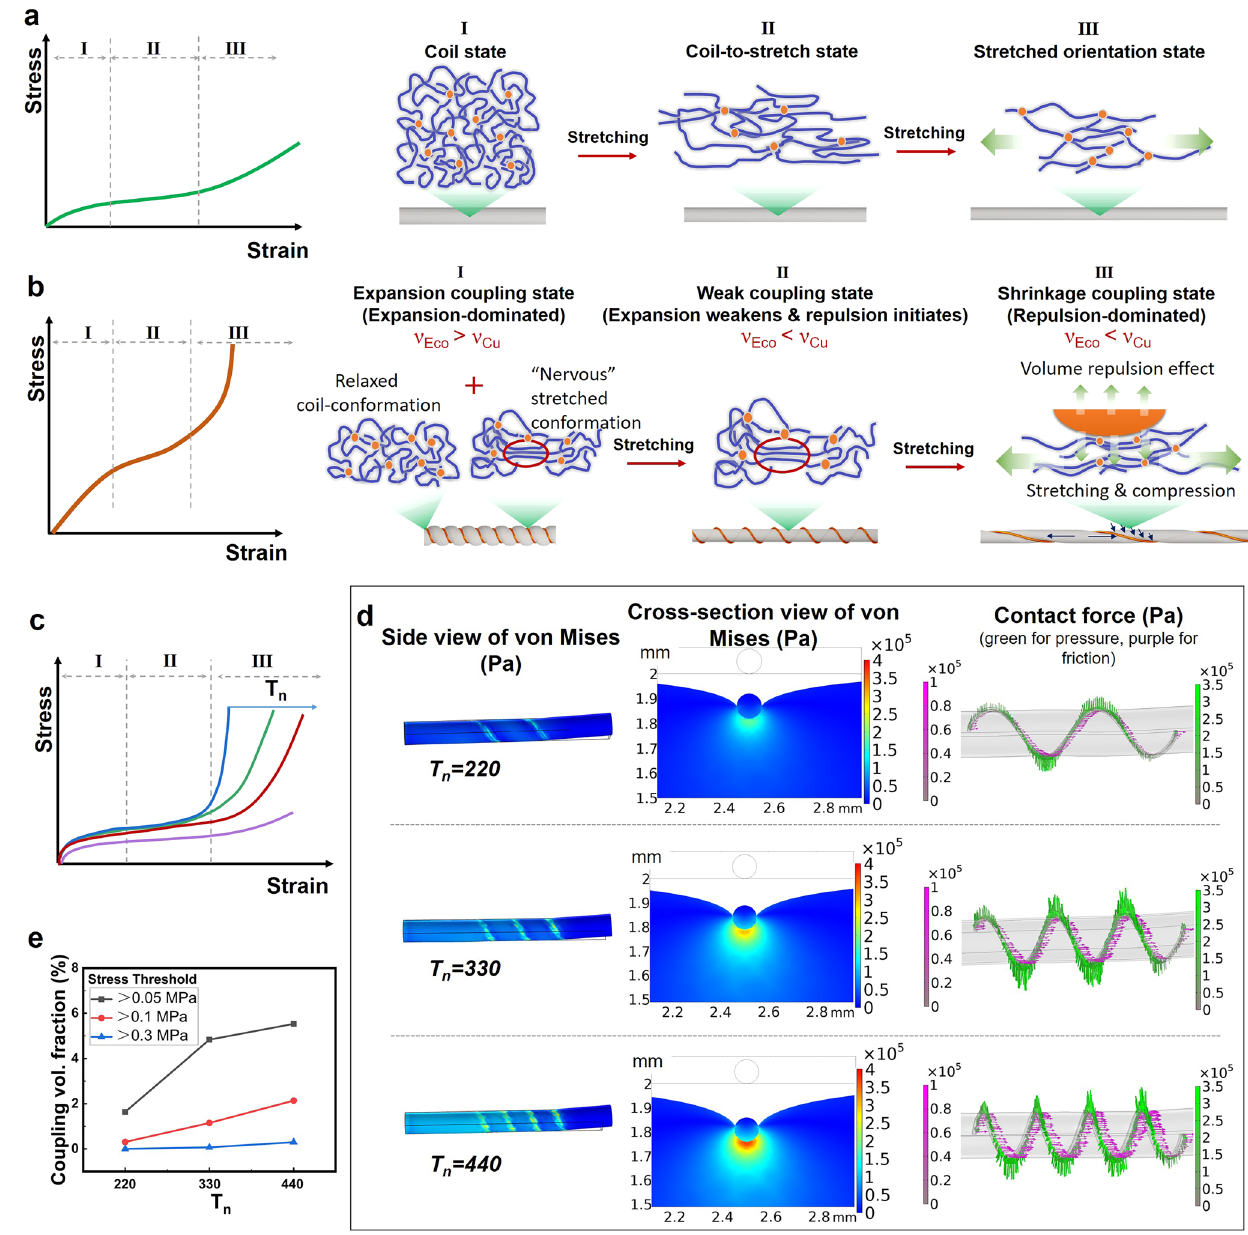
Fig. 4 A conformation coupling mechanism for understanding the mechanical properties of the HFCs. a Schematic of elastomer chain conformation changes during stretching without the coupling effects from the wire macro-helix conformation. b Schematic of the elastomer chain conformation changes for the HFC with strong coupling effects from the macro-helix conformation. ν is Poisson ’ s ratio. c Illustration of tuning the stress – strain curves of HFC by torsion number, T n . d Simulation study of the mechanical coupling for the HFC with different T n based on fi nite element analysis by COMSOL Multiphysics. The coupling effects can be described by the von Mises distribution caused by the compression of the helix conformation. e The dependent behavior of coupling volume fraction inside the elastomer on the torsion number, T n To demonstrate this great potential, the coupling effects were further studied by fi nite element analysis by using COMSOL Multiphysics, and the results are shown in Fig. 4d. Here, to simulate the conformation coupling, the elastomer is pre- stretched with a strain of 200% as employed in experiments.